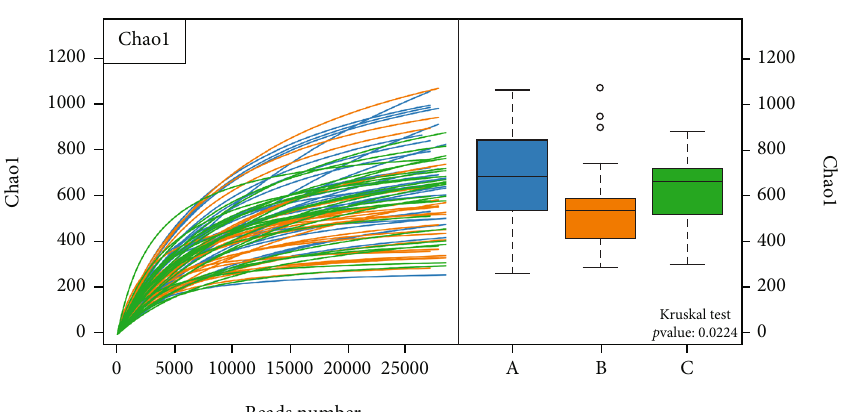
Figure 1: Diversity analysis of 16S rRNA gene sequences obtained from fecal samples of groups A (children with Henoch-Schonlein purpura), B (children with Henoch-Schonlein purpura nephritis), and C (healthy